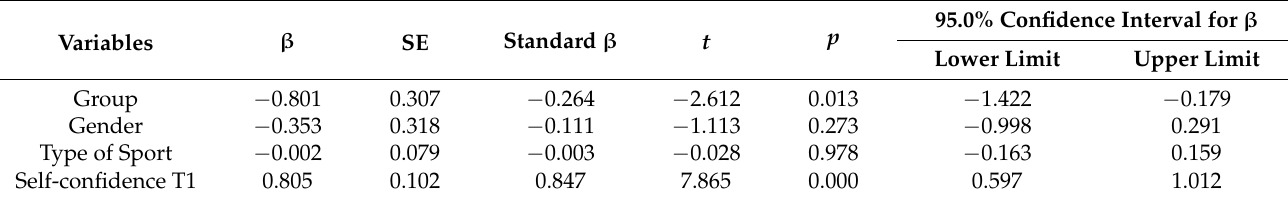
Table 3. Linear regression of factor associated with self-confidence in